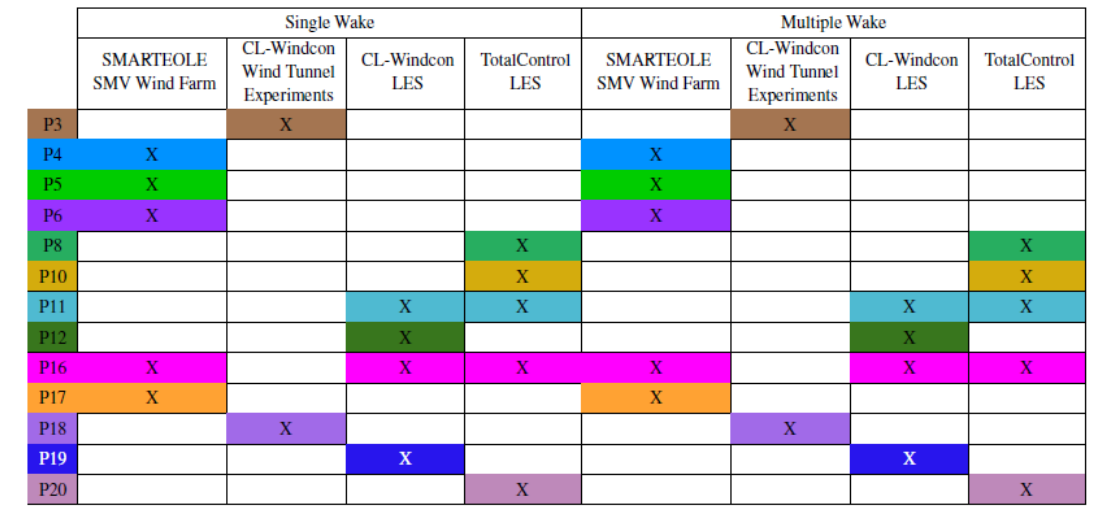
Table 1. Overview of the FarmConners benchmark participants (participant IDs P3–P20) per test case, per blind test. WFFC-oriented model comparison is performed separately for each column. The participants are colour coded for easy access through the article, where CL- Windcon wind tunnel experiments blind test results are discussed in Part 2 of the series.